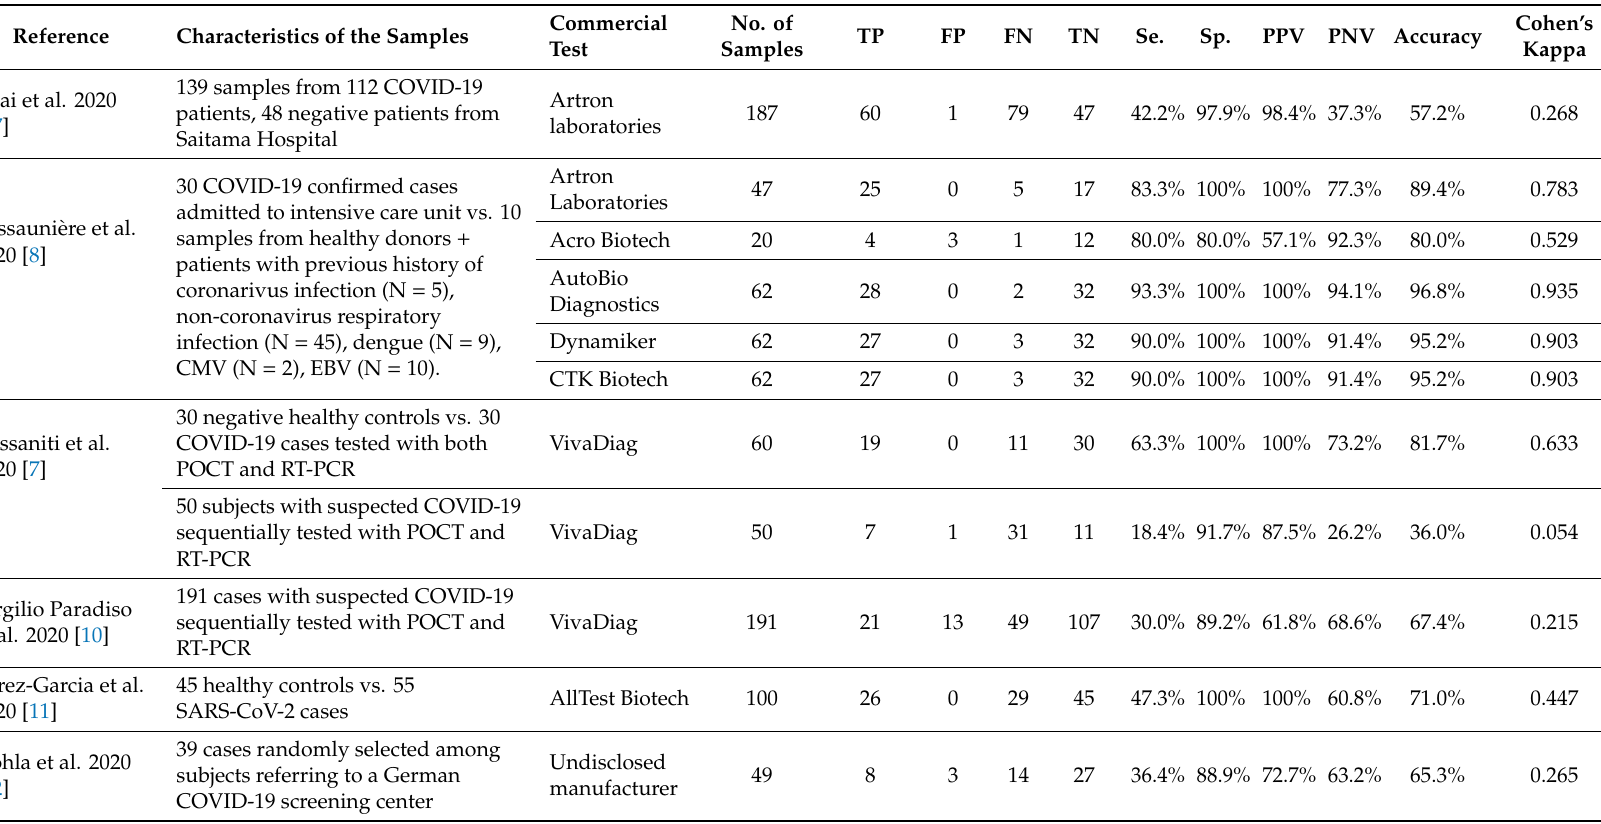
Table 1. Summary of studies included in the meta-analysis (Note: TP = No. of True Positive Cases; FP = No. of False Positive Cases; FN = No. of False Negative Cases; TN = No. of True Negative Cases; Se. = sensitivity; Sp. = specificity; PPV = predicted positive value; PNV = predicted negative value; Cohen’s Kappa values should be interpreted as follows: 0.0–0.20 no agreement, 0.21–0.39 minimal agreement, 0.40–0.59 weak agreement, 0.60–0.79 moderate agreement, 0.80–0.90 strong agreement, > 0.90 almost perfect agreement; POCT = Point-of-Care